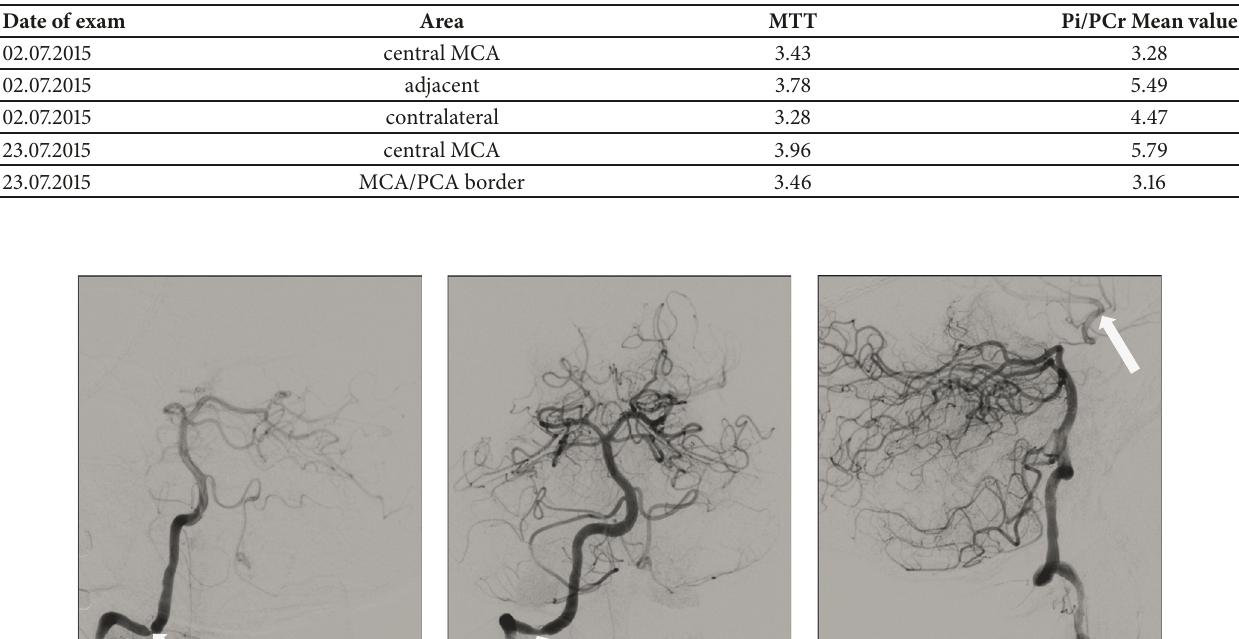
Table 1: Results of mean transit time (MTT, given in seconds) and inorganic phosphate to phosphocreatine ratio (Pi/PCr, given in arbitrary units).